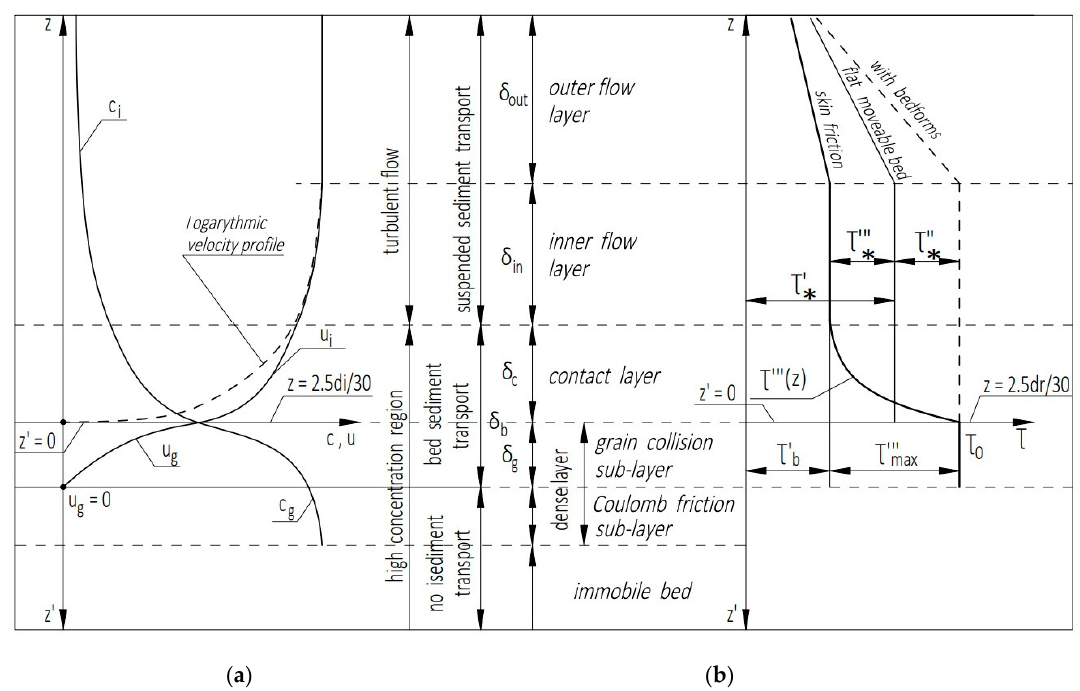
Figure 8. Vertical structure of: ( a ) sediment transport profile with velocity and concentration of the i- th fraction of sediment; ( b ) shear stress profile; after Kaczmarek et al. [51] with modification for non-uniform sediments.